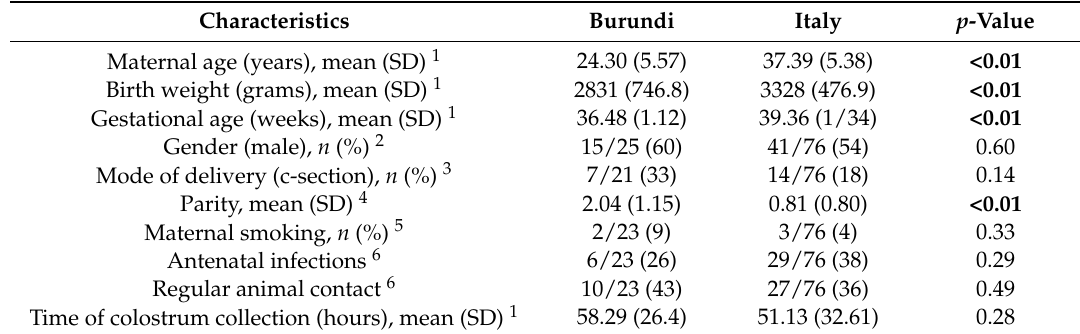
Table 1. Characteristics of study participants between sites of